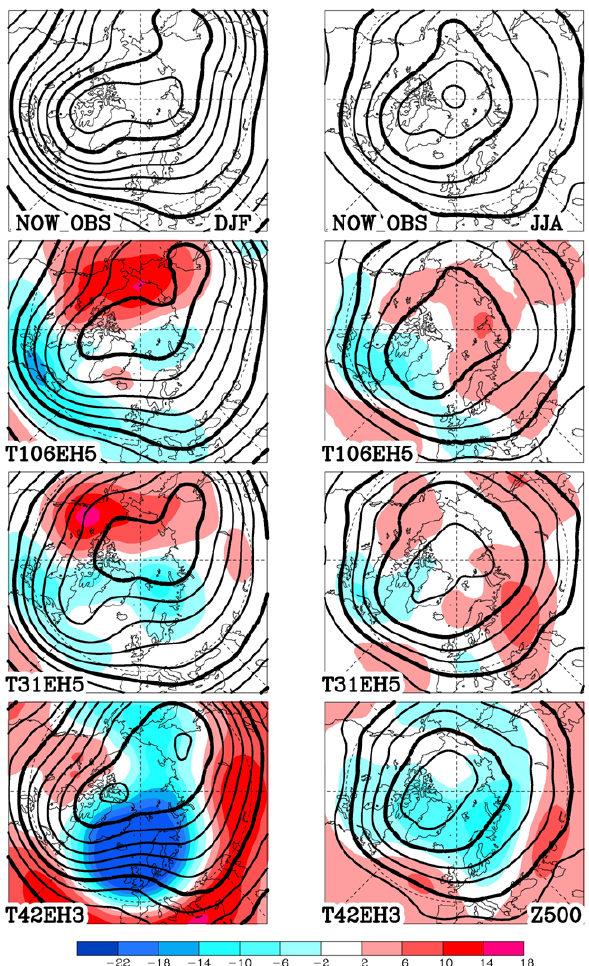
Fig. 3. 500hPa geopotential height field for the present (heavy lines) overlaid by the difference LGM-NOW (in colours). Contours for the height field every 8dam (geopotential decametres), high- lighted lines for 516 and 556dam in DJF (left) and for 556 and 580 dam in JJA (right). Contours for the differences at ± 2, 6, 10, 14, 18dam, blue colours for LGM – NOW values < − 2, red > +